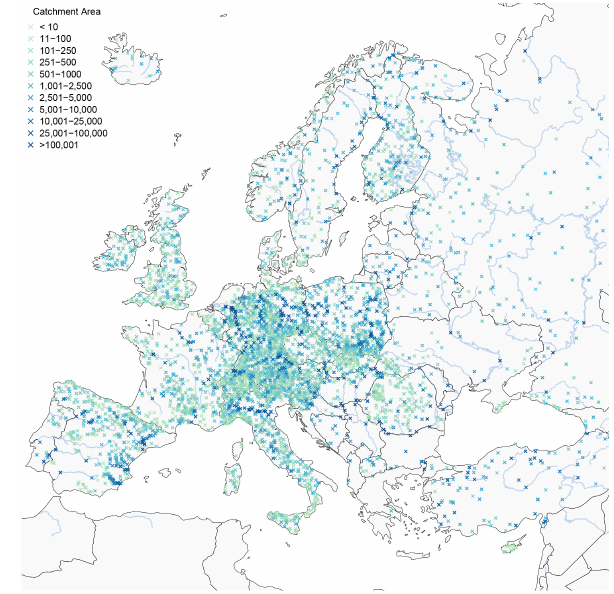
Figure 6. First year of record of the annual maximum